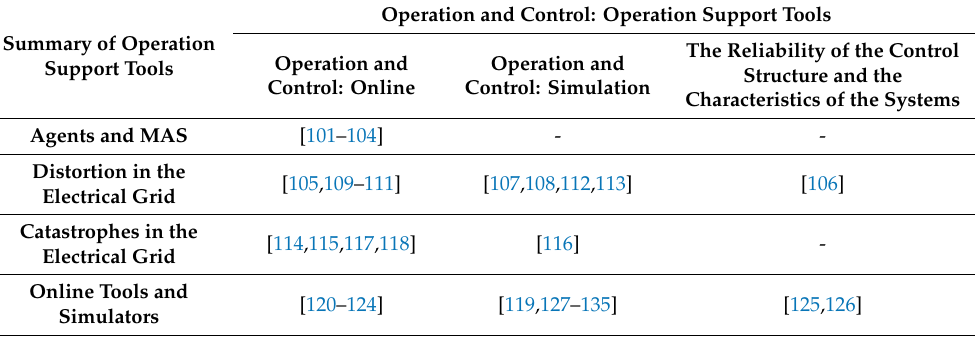
Table 5. Summary of Operation Support